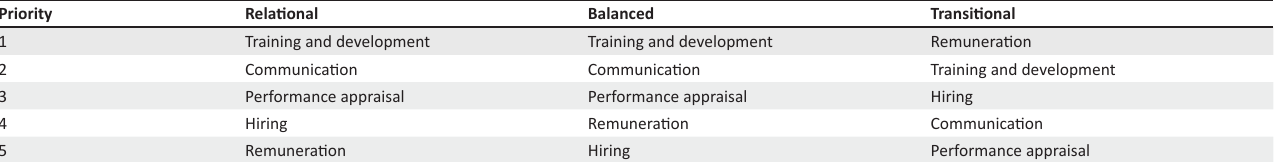
TABLE 12: Human resource practices in order of importance for creating specific psychological contracts.